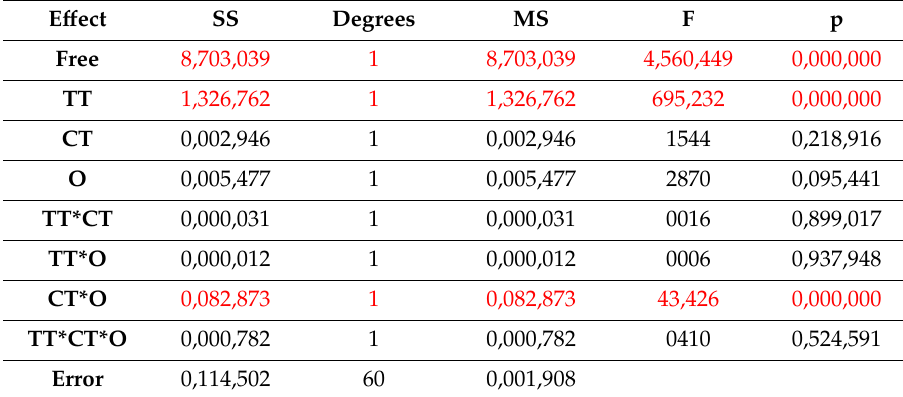
Table 4. One-dimensional significance test for K coe ffi cient (kNm / rad).